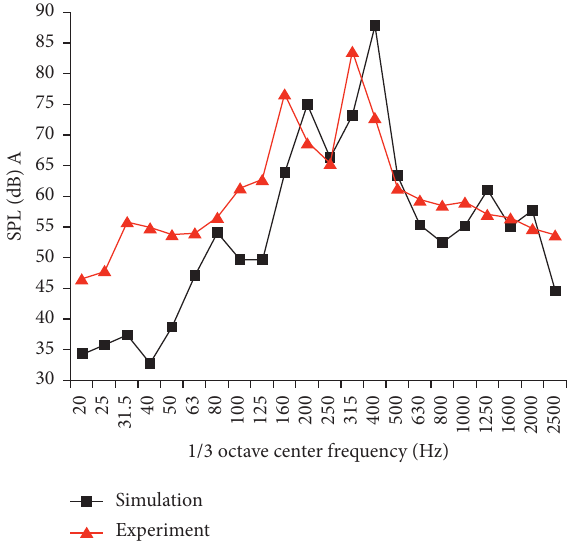
Figure 15: The comparison of the experiment and simulation on the 1/3 octave centre